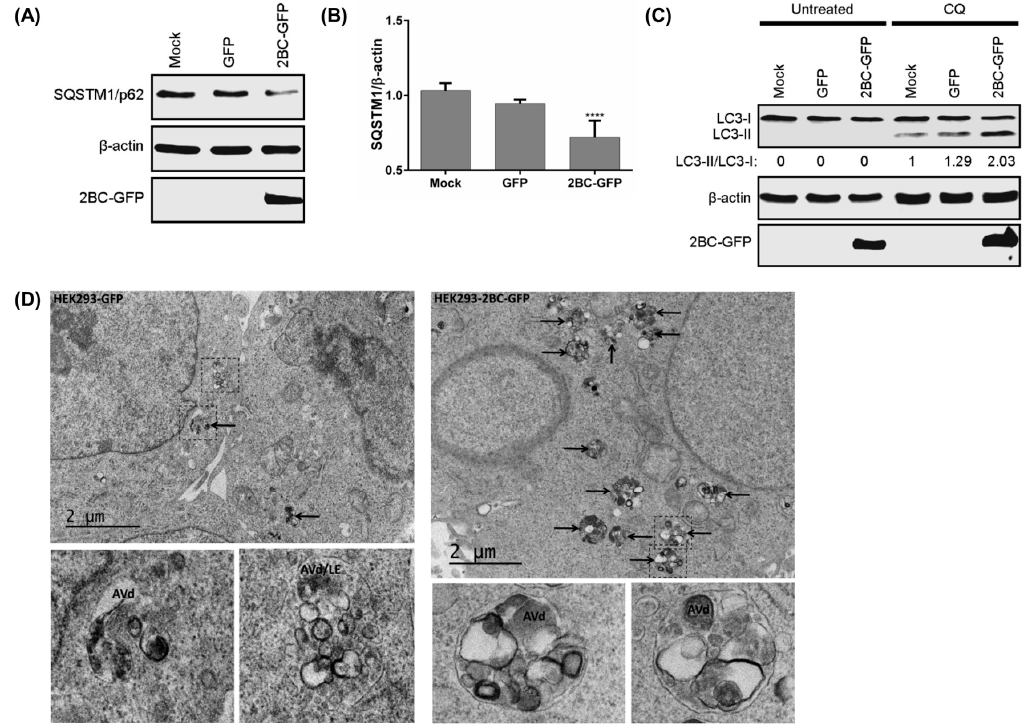
Figure 3. 2BC non-structural protein of EV-A71 triggers autolysosome formation. ( A ) HEK-293 cells were transfected with eGFP-tagged 2BC for 48 h to detect sequestosome-1 (SQSTM1/p62) and GFP fusion proteins by Western Blot; and ( B ) SQSTM1/ β -actin ratio was determined; ( C ) HEK-293 cells were transfected as in ( A ) for 24 h and treated with 50 µ M chloroquine (CQ) for another 24 h prior to ( C ) WB; ( D ) HEK293/LC3 stable cells were transfected with 2BC as in ( A ) for transmission electron microscopy. AVd and black arrows indicate late autophagic vacuoles while LE indicates late endosomes. AVd/LE denotes putative amphisomes, organelles resulting from fusion of autophagic vacuoles with multivesicular late endosomes. Error bars, means ± SD of 3 independent experiments. One-way ANOVA: **** p < 0.0001.